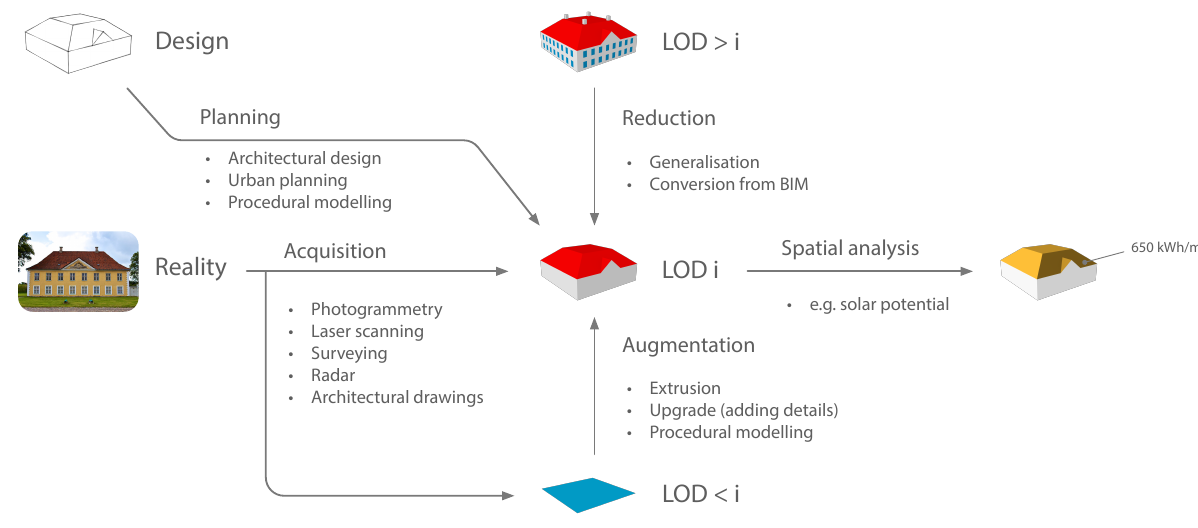
Figure 2: Life cycle of a 3D city model: different production workflows of 3D city models from the perspective of the level of